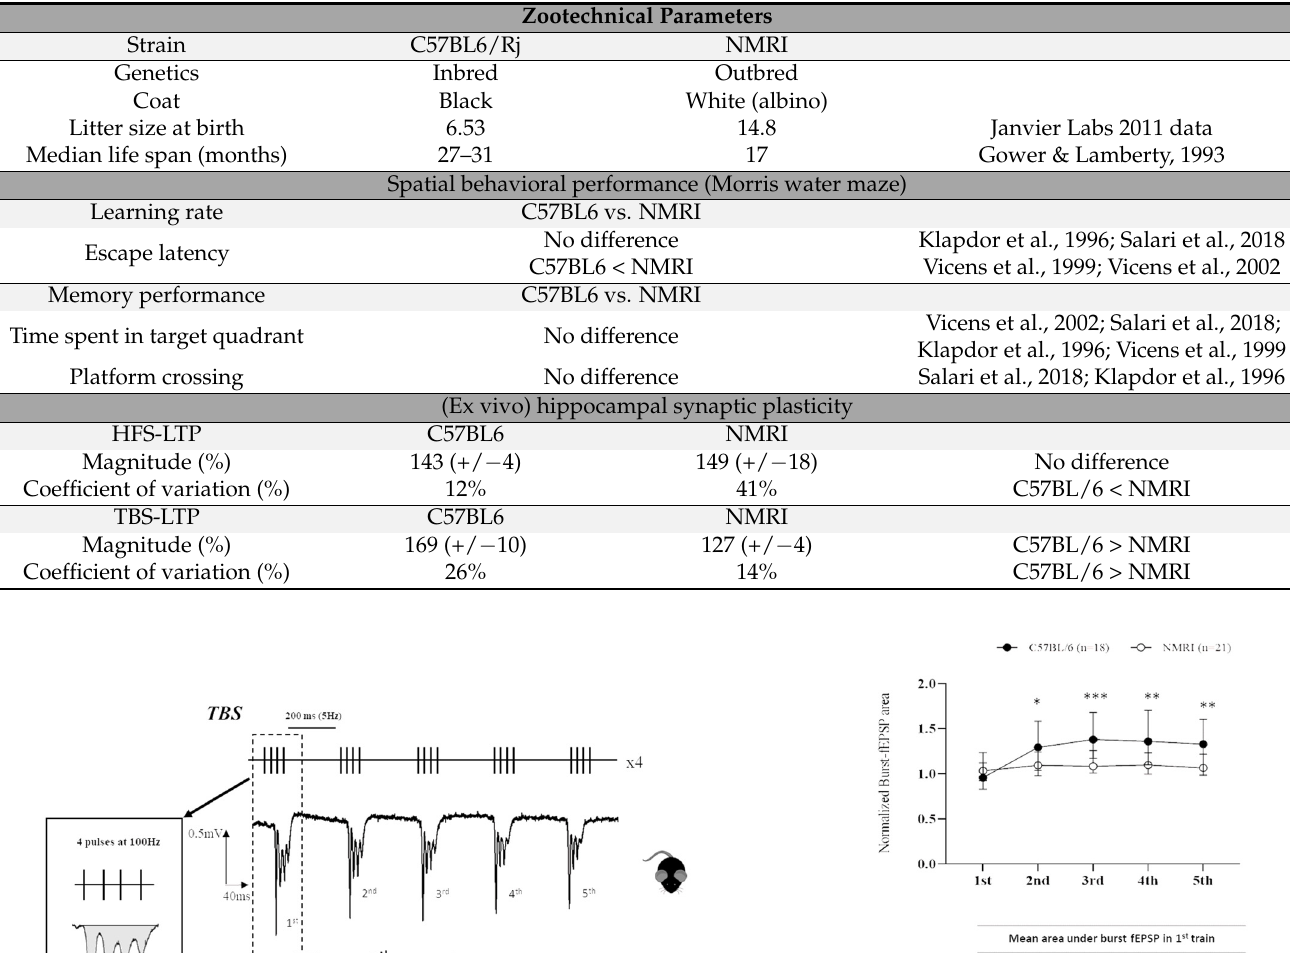
Table 1. Summary of phenotypic properties and main electrophysiological results in C57BL/6 and NMRI mice.